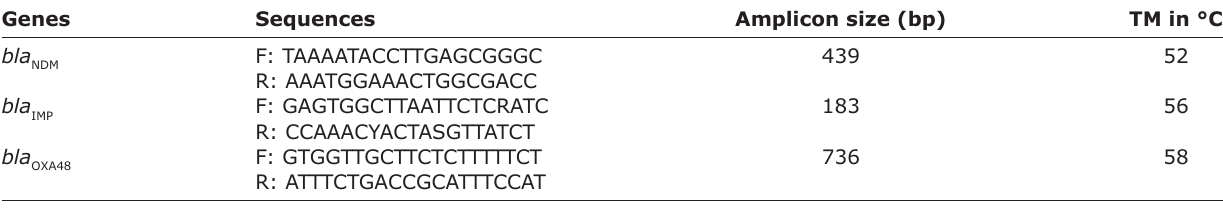
Table-1: The sequences, amplicon size, and annealing temperature of polymerase chain reaction primers using amplify drug resistance genes of Escherichia coli [8].